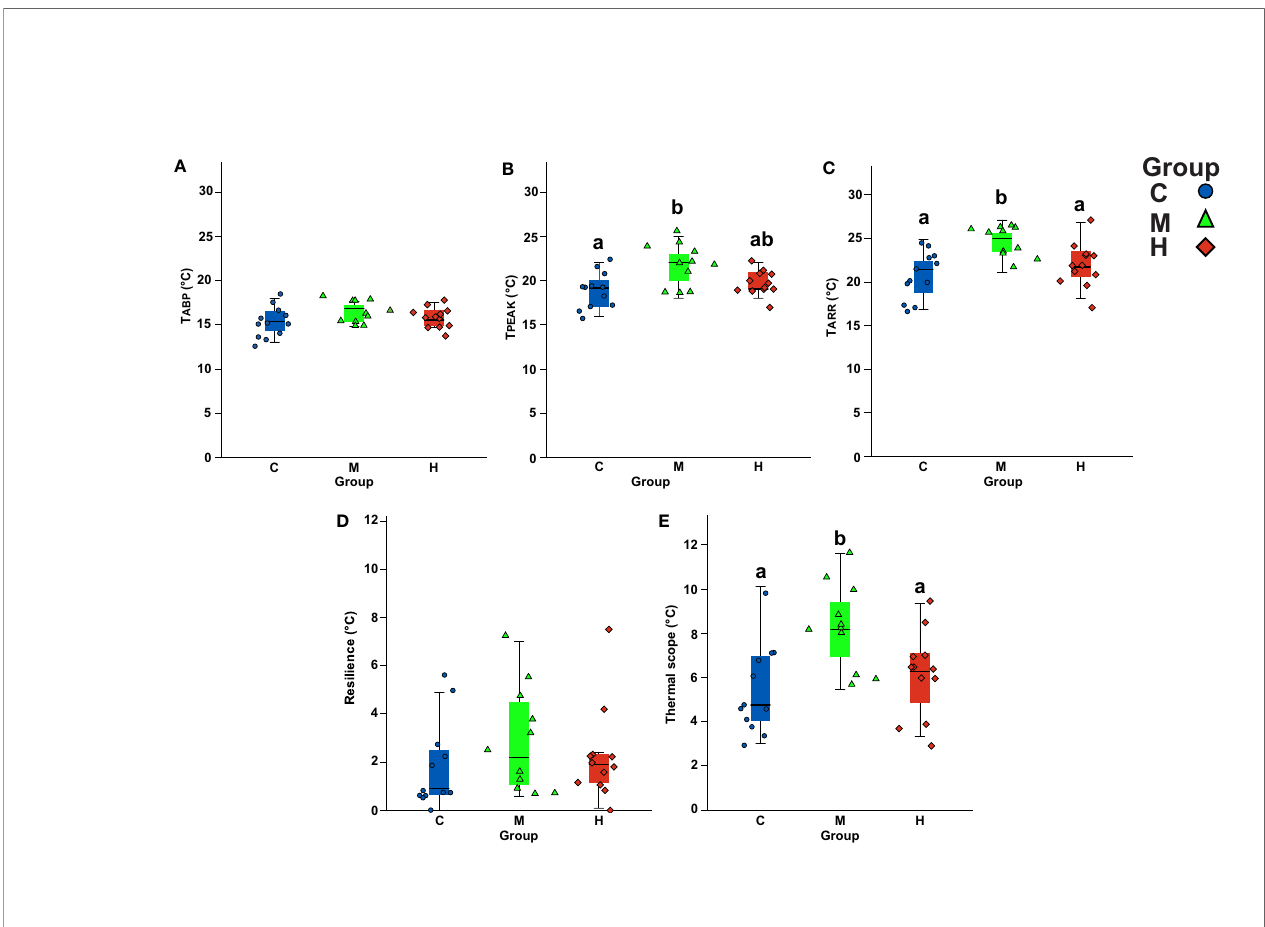
FIGURE 2 | The effects of training programmes on the cardiac transition temperatures. Boxplots of the Arrhenius break point temperature (T ABP ) the f H max (A) , the temperature where the fi sh achieved the peak of the f H max (T peak ) (B) , the temperature where the fi sh developed the arrhythmia (T ARR ) (C) , the scope of the heart thermal resilience (D) , and the thermal scope of the heart function (E) . The different letters represent signi fi cant difference (p < 0.05) among the groups (Control=C, blue circles, n=12; Medium intensity=M, green triangles, n=11; High intensity=H, red squares,